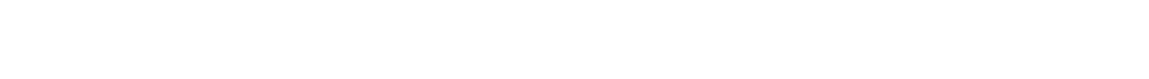
Tabelle 3. Die Ermittlung der Abweichung des Mittelwertes des Niitzlichkeitsgrades des Bewertungsobjektes und des priizisierten Wertes, sowie die Festlegung des Verkehrswerts Table 3. Determining the average deviation of utility and market value of an object valuated, variation of corrected